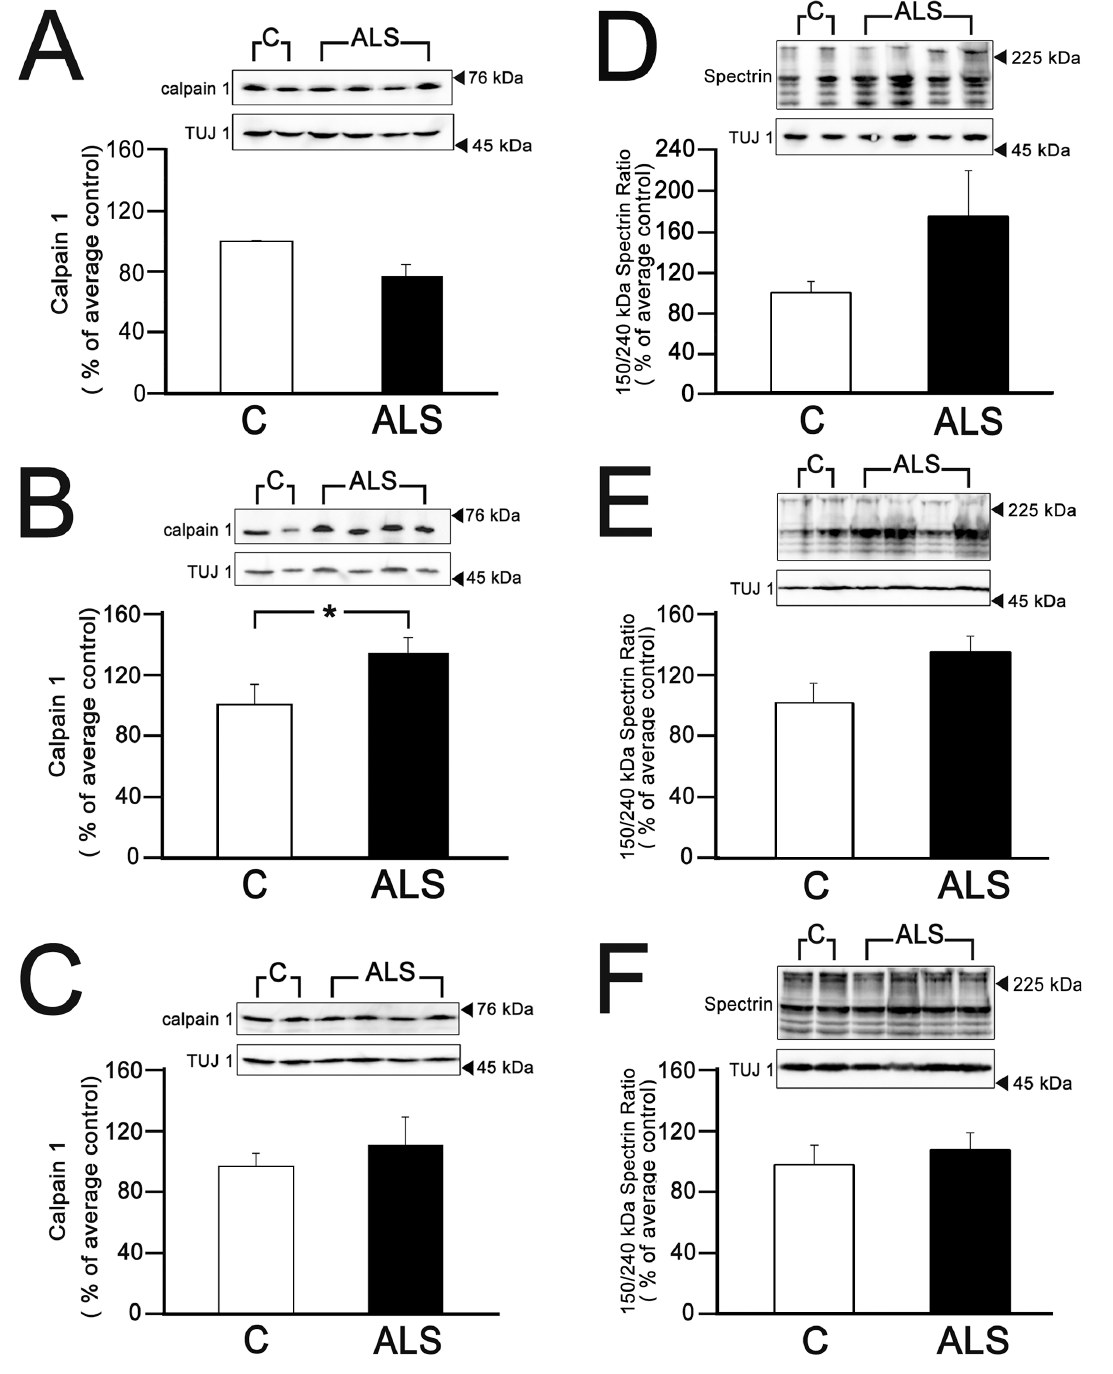
Figure 4. Determination of calpain content and activity in spinal cord and precentral gyrus in ALS subjects. (A–C) Western blot analysis of calpain content and (D–F) calpain activity, by means of spectrin degradation, in homogenates prepared from postmortem samples of lumbar (A and D) and cervical (B and E) spinal cords, and prefrontal cortex (C and F) samples obtained from ALS and age-matched control subjects. Graphs show calpain levels and calpain activity, as the ratio 150/240 kDa spectrin bands, in control and ALS subjects. Numbers represent the mean ± SEM of control and ALS samples as described in Figures 1 and 2 legends. Values are expressed as per- centage of controls, considering the values obtained in control subjects as 100%. Class III β tubulin (TUJ1) was used as loading control. *Differs from control subjects; P <